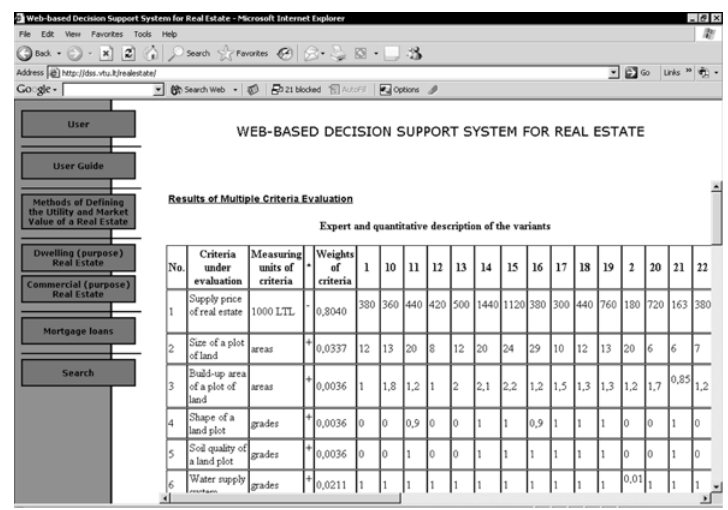
Figure 2. Expert and quantitative description of the real estate’s alternatives (initial negotiation table)